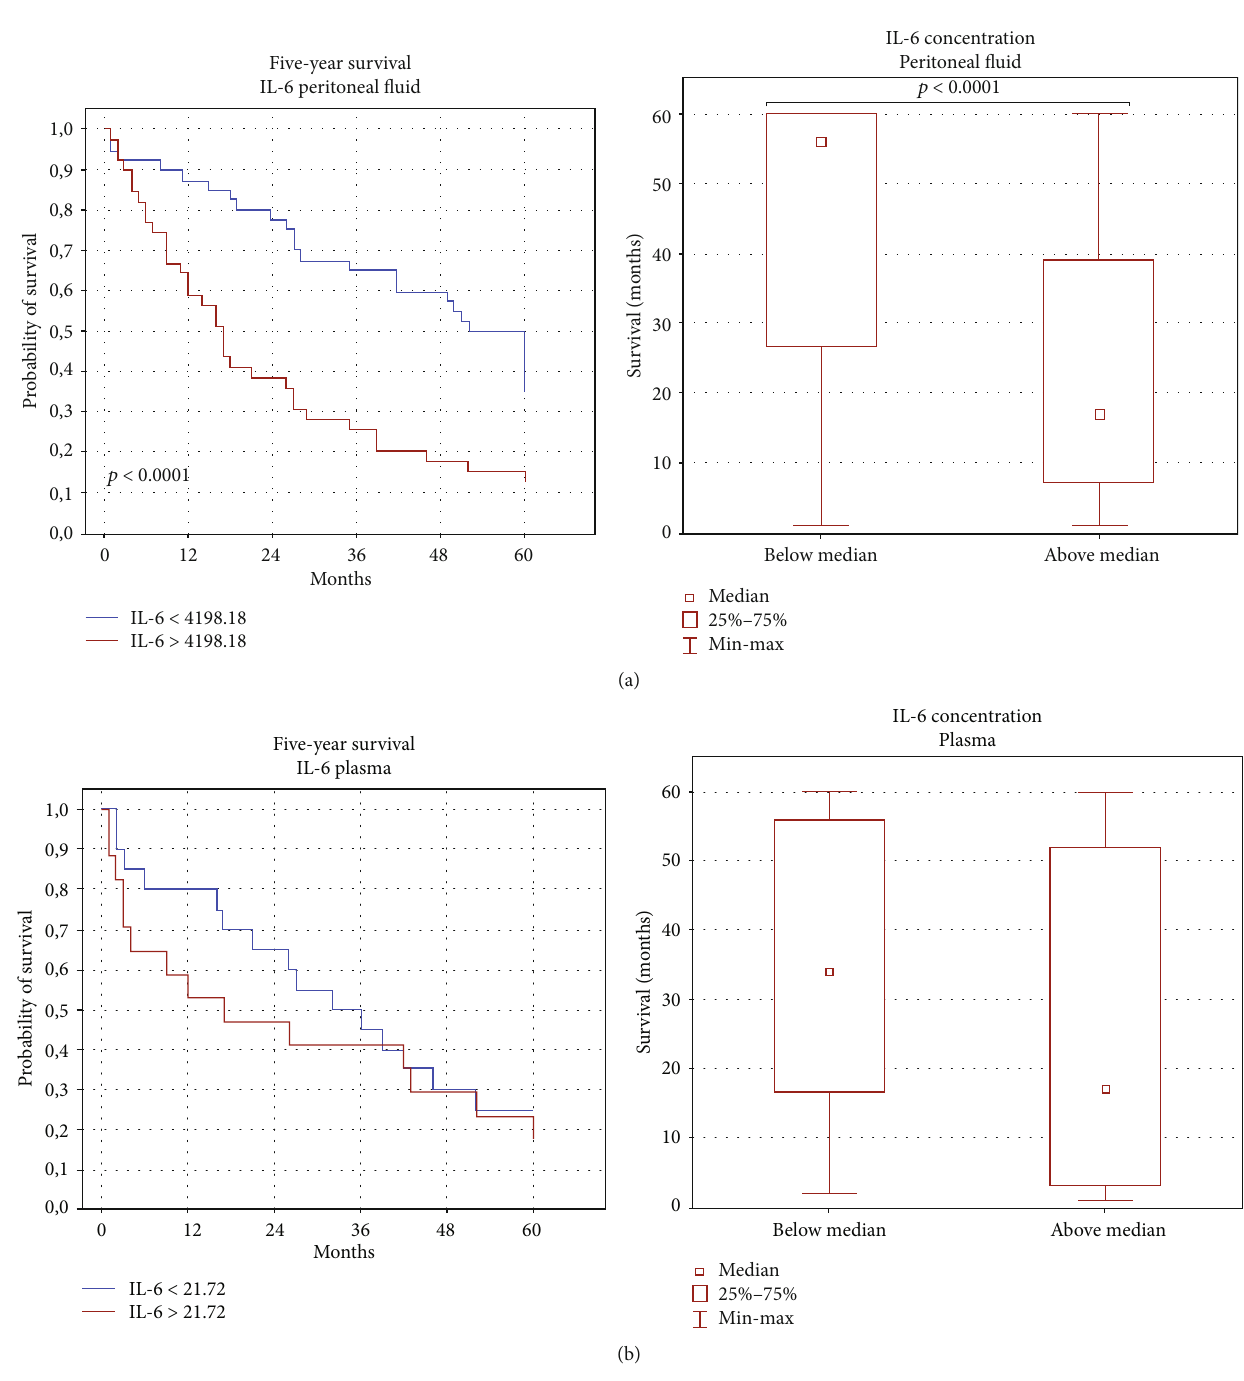
Figure 8: Relationship between the (a) ascites and (b) plasma IL-6 levels and 5-year survival of OC